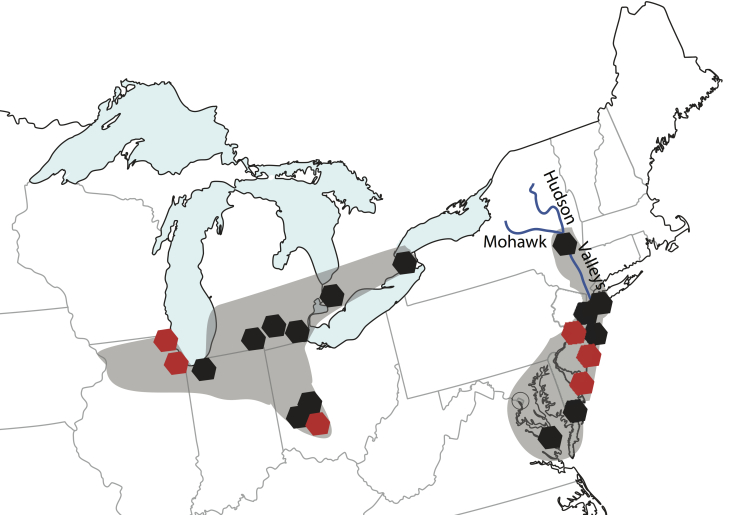
Sites are modified from 34,35 based on literature and collection records. The collection localities of museum samples used in this study are indicated in red.